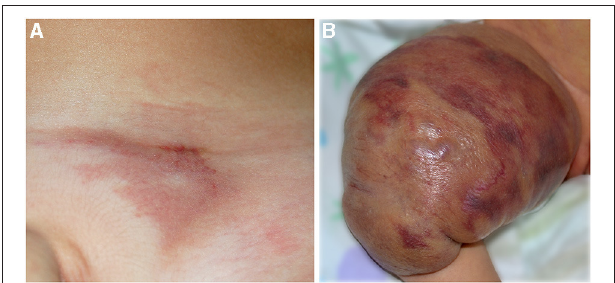
FIGURE 7 | Red vascular plaque of the pubic area in a toddler (A) ; the lesion is painful and warm. Voluminous vascular tumor characterized by red brilliant purpuric color associated with the Kasabach–Merritt phenomenon in a newborn (B)